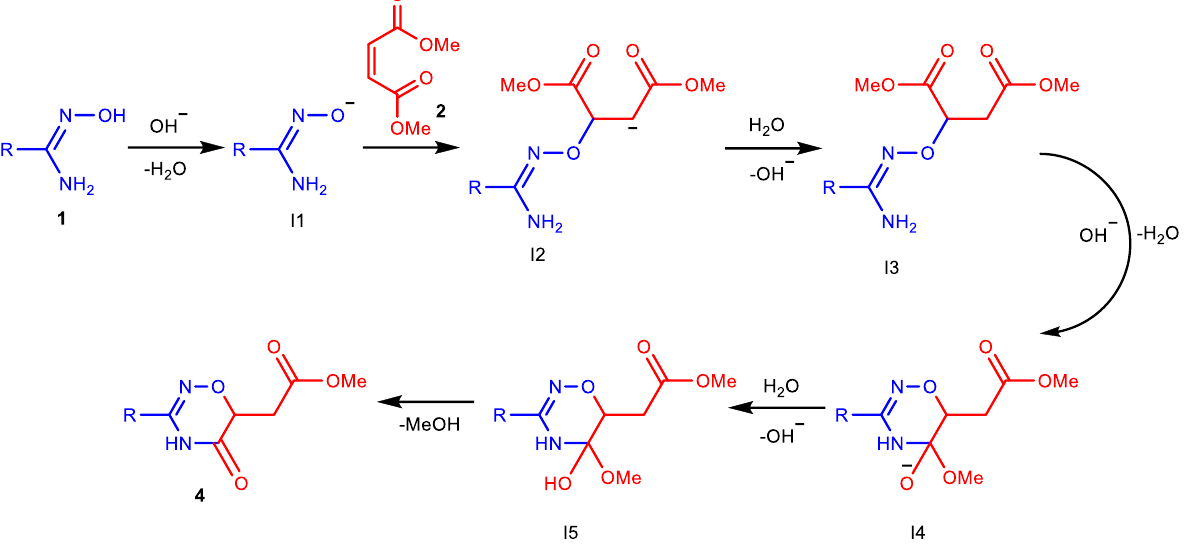
Figure 1. Hydrogen-bonded dimers in crystals of 4d ( A ), 5b ( B ), and 5f ( C ).